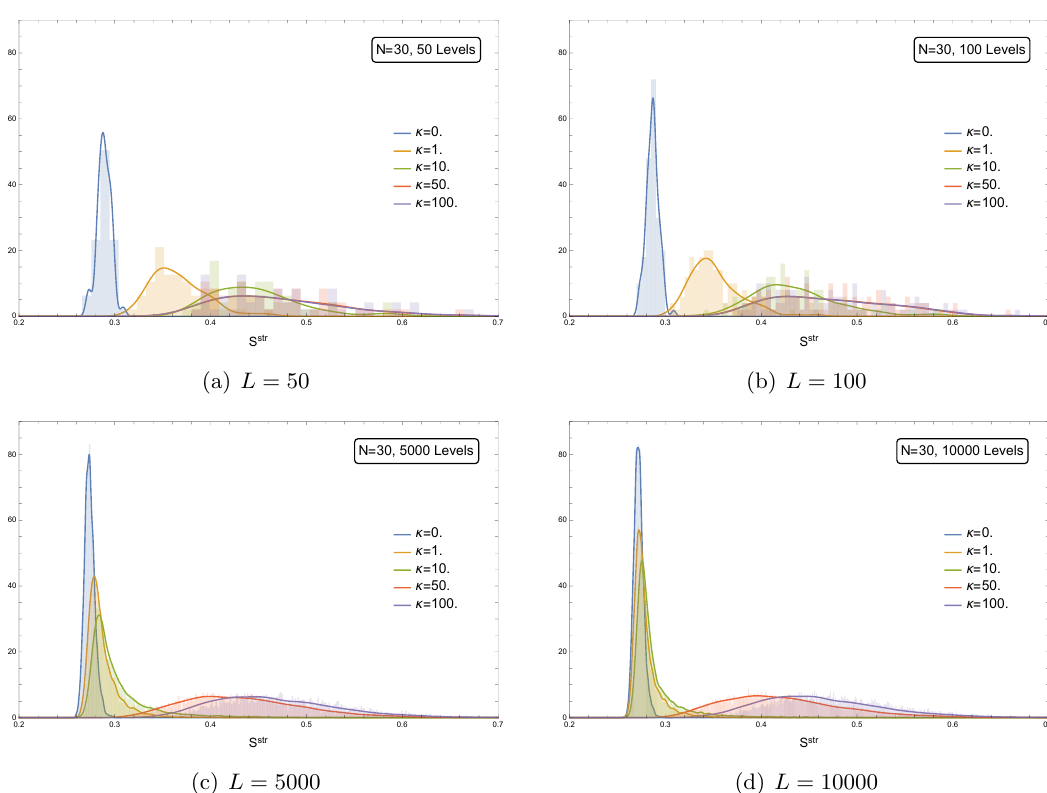
(i.e., large (cid:20) ) of the SYK model is close to those of the GOE although the shape of the distributions are di(cid:11)erent and hence, simply from the mean value of the IPRs, one cannot distinguish the integrable behavior from the GOE behavior. But, the averaged structural entropy of the integrable regime (e.g., (cid:20) = 1000) is 0 : 482 (see (cid:12)gure 14(c)), which is far from the structural entropy (cid:25) 0 : 369 of the GOE class (see (cid:12)gure 14(a)). The structural entropy also show the di(cid:11)erent chaotic/integrable transitions of the tails and the bulk of spectrum (see (cid:12)gure